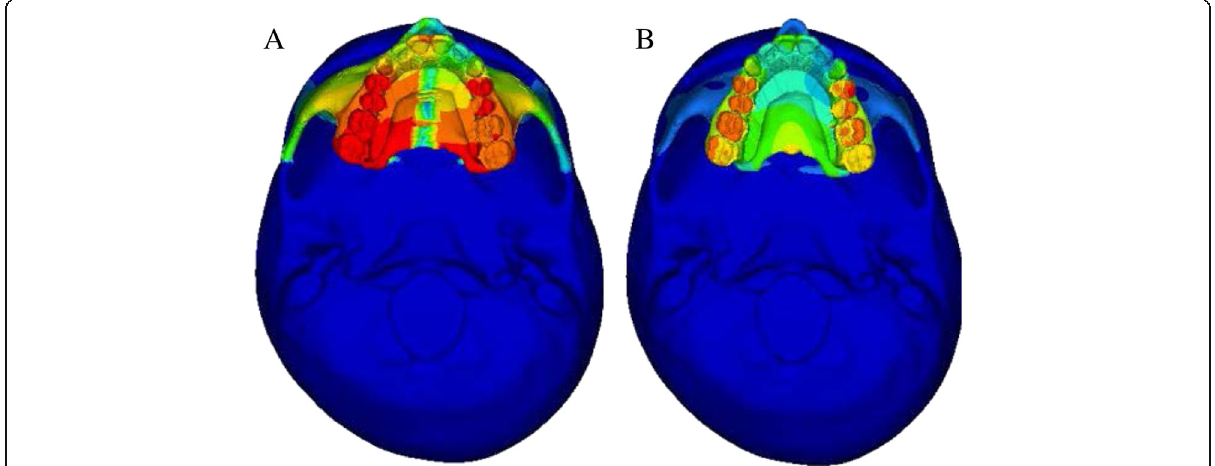
Fig. 6 Overall skull view after application of the forces. a Without implants. b With